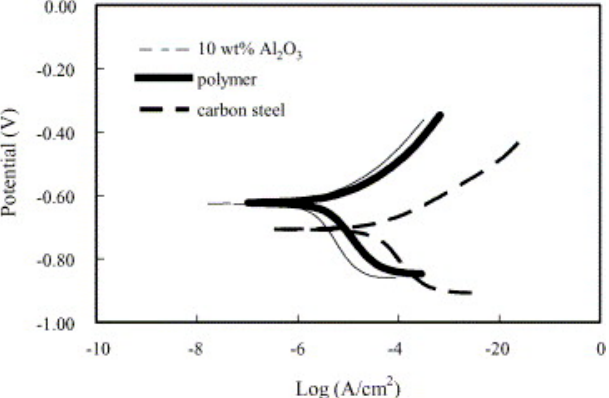
Figure 17. Potentiodynamic curves in 3 wt.% NaCl solution for bare carbon steel compared with that for carbon steel coated with polymer and coated with 10 wt.% Al 2 O 3 filler added to the polymer coating [128].